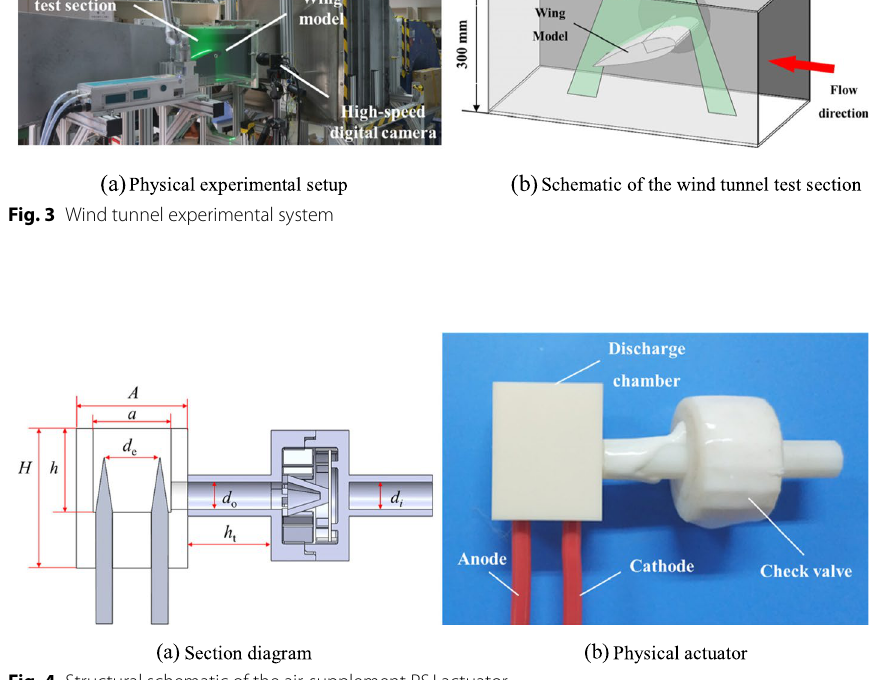
Fig. 4 Structural schematic of the air‑supplement PSJ